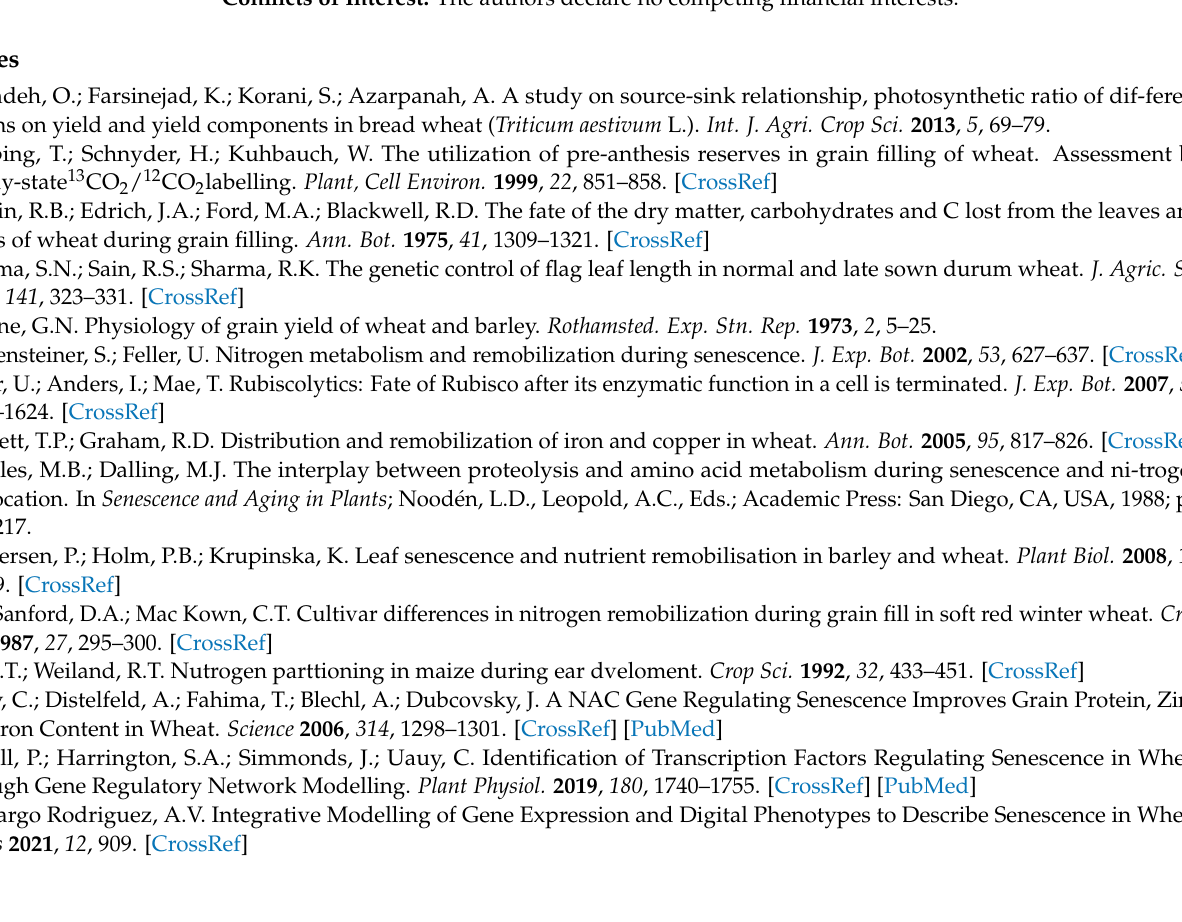
identified as putative SAGs; Table S4: Transporter-related SAGs; Table S5: Transcription factor-related SAGs; Table S6: Phytohormone-related SAGs; Table S7: Chlorophyll-related